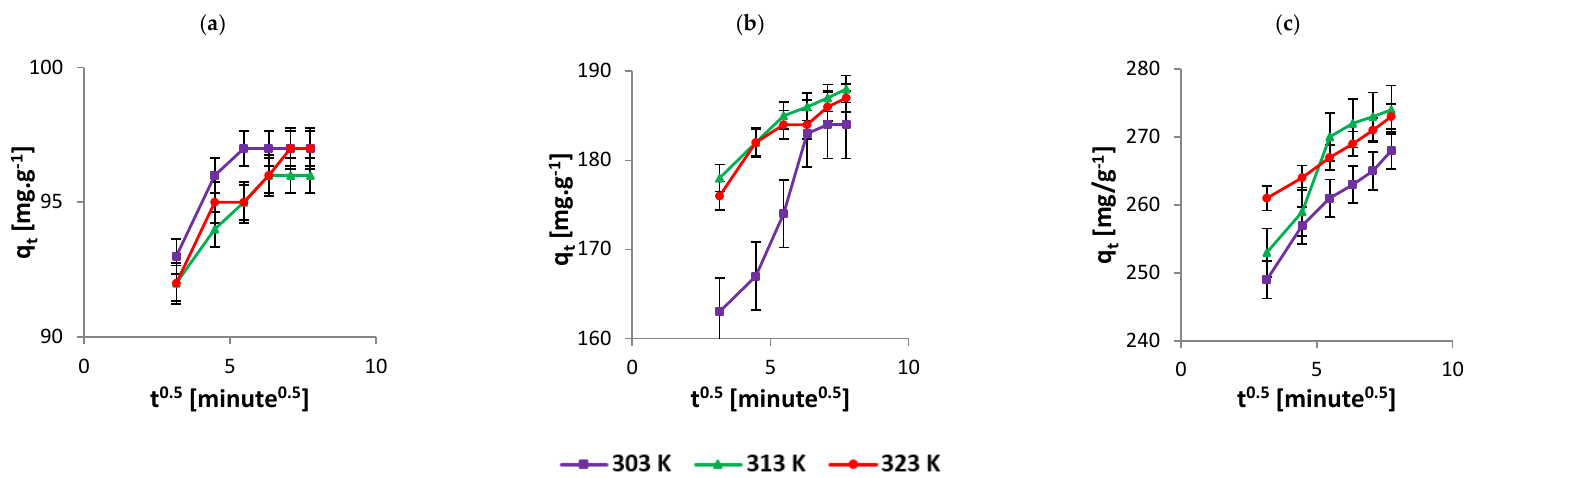
Figure 3. Kinetics data fitted to the Weber – Morris model with initial AR119 dye concentration ( a ) 100 µg mL −1 , ( b ) 200 µg mL −1 and ( c ) 300 µg mL −1 .